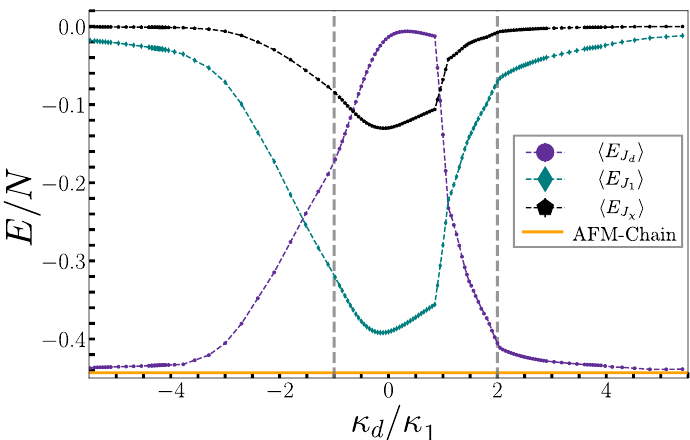
Figure 7: Variational energy E = 〈 Ψ | H | Ψ 〉 as a function of κ for h = 0 obtained via d VMC. We calculate the expectation values of all three terms in Eq. (1): chiral term (black curve), Heisenberg J (green curve) and J (purple curve) terms. For com- d 1 parison, we show the exact ground state energy of the antiferromagnetic Heisenberg chain (orange line). The vertical dashed lines indicate the region of stability for the CSL ansatz as discussed in Sec. 4. We considered L = 12 and error bars are smaller than the symbol